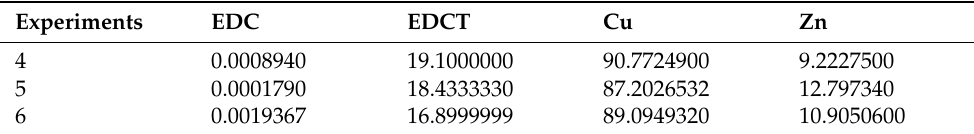
Table 10. Decision matrix.